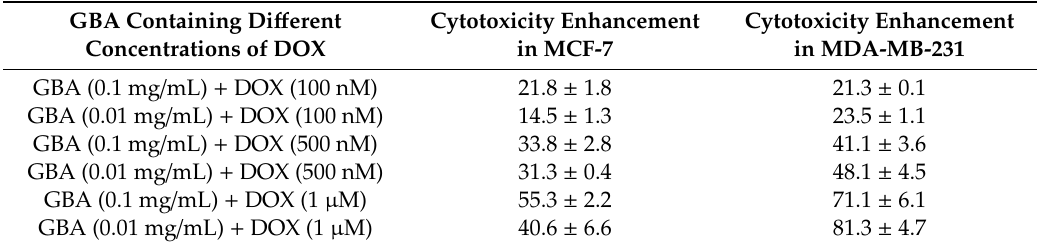
Table 5. Cytotoxicity enhancement of DOX-loaded GBA in MCF-7 and MDA-MB-231 cells.